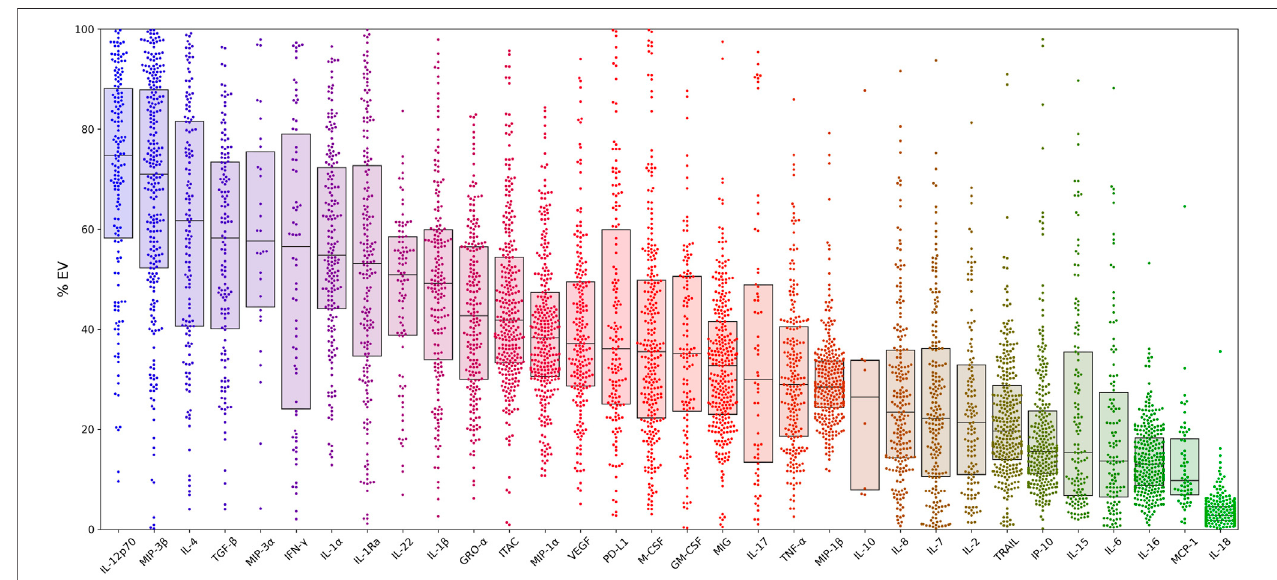
FIGURE1| Percent distributions of 32 cytokines within extracellular vesicles for the entire cohort. Cytokine concentrations for all patients are calculated as the EV concentration divided by the sum of the EV and soluble concentrations. Box plot overlays show the medians and interquartile ranges. Samples with concentrations at the lower limit of detection (LLOD) were excluded from the analysis. In addition, three cytokines (RANTES, IL-13, IL-21) were excluded from analysis due to concentrations being above or below detection limits and/or due to high background. Abbreviations: α = alpha, β = beta , EV = extracellular vesicle, GM-CSF = granulocyte-macrophage colony-stimulating factor, GRO- α = growth-regulated alpha, IFN- γ = interferon- γ , IP-10 = interferon- γ -induced protein, IL = interleukin, ITAC = interferon-inducible T-cell alpha chemoattractant, M-CSF = macrophage colony-stimulating factor, MCP-1 = monocyte chemoattractantprotein-1,MIG=monokineinducedbyIFN- γ ,MIP-1 α =macrophagein fl ammatoryprotein-1 α ,PD-L1=programmeddeath-ligand1,RA=receptor antagonist, TGF- β = transforming growth factor beta, TNF- α = tumor necrosis factor- α , TRAIL = TNF- related apoptosis-inducing ligand, VEGF = vascular endothelial growth